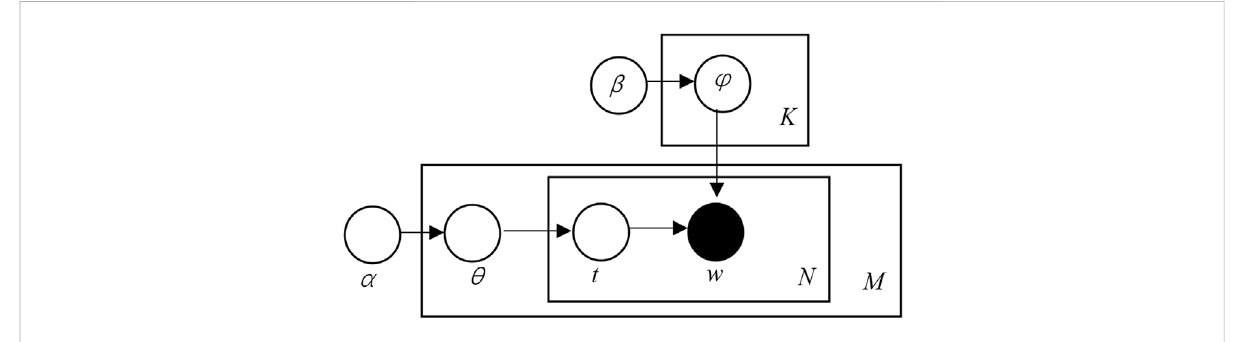
FIGURE 1 Principle of the LDA model.